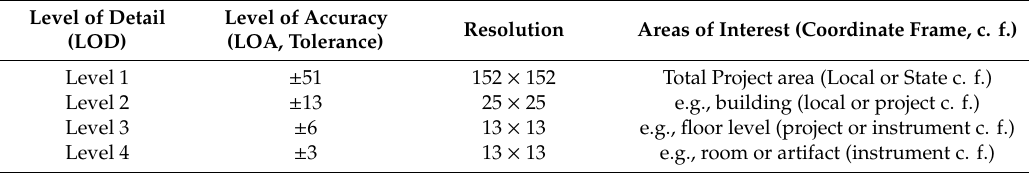
Table 3. Data quality parameters defined by U.S. General Services Administration (GSA) for registering point clouds. (Unit: Millimeters). Level of Detail (LOD)